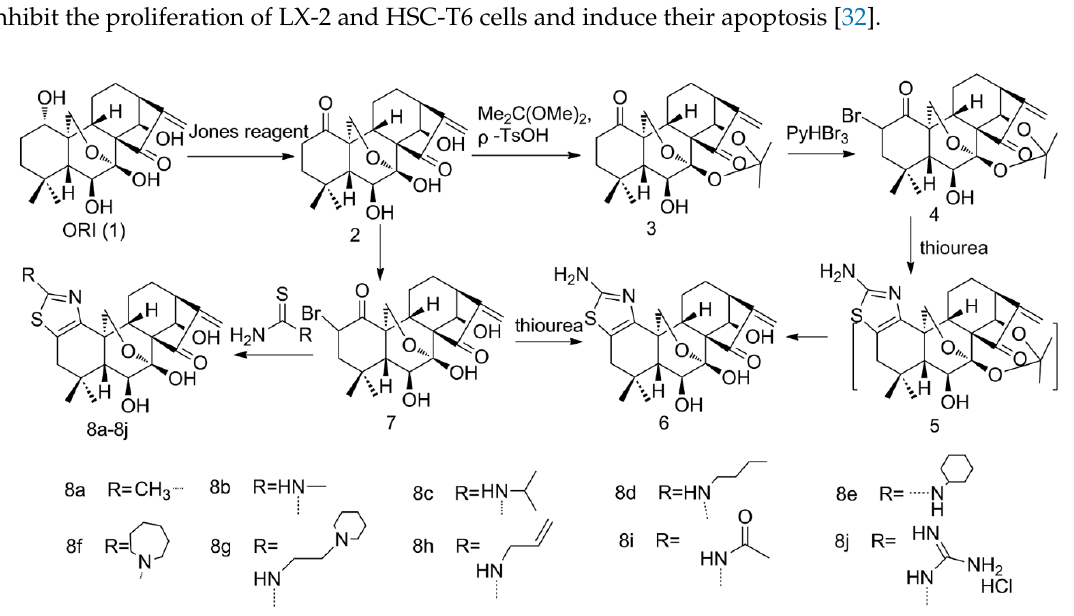
Figure 2. Routes for introduction of thiazole rings at the C( 1 ) and C( 2 ) sites on ORI.